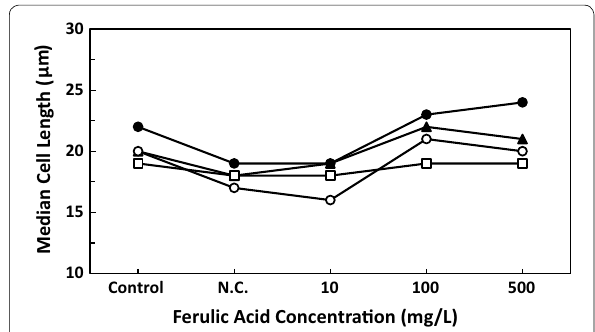
Fig. 3 Effect of ferulic acid on the median cell length Euglena gracilis under different light conditions. N.C. negative control group. Symbols correspond to (black circle) light 6 h, (black up‑pointing triangle) light 12 h, (white square) dark 6 h, (white circle) dark 12 h